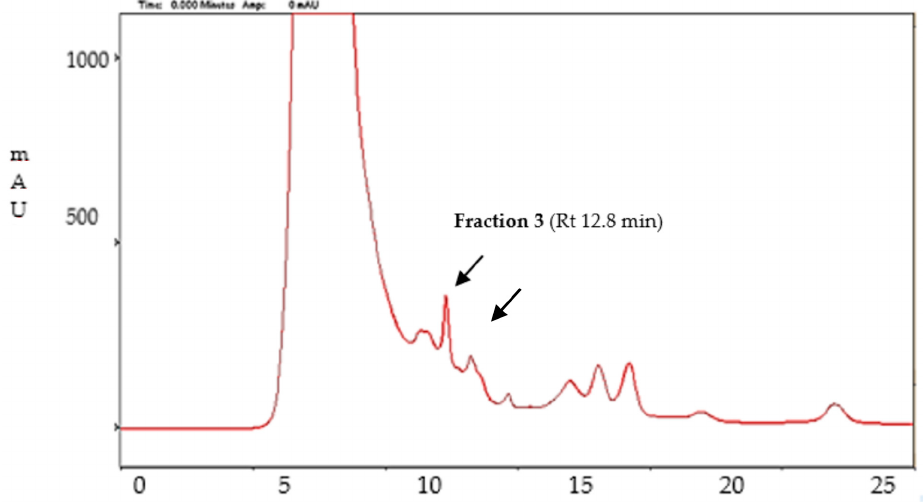
Figure 5. Chromatogram of T. afroharzianum T22 culture filtrates obtained by HPLC separation. Arrow indicates the fraction (number 3, Rt 12.8 min) with the best degradation